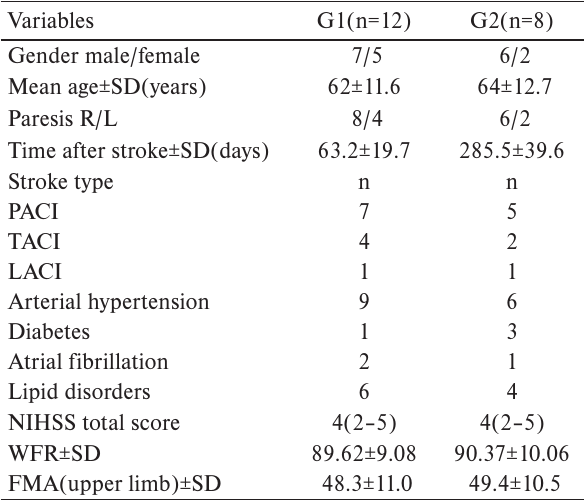
Table 1. Clinical characteristics of participants.